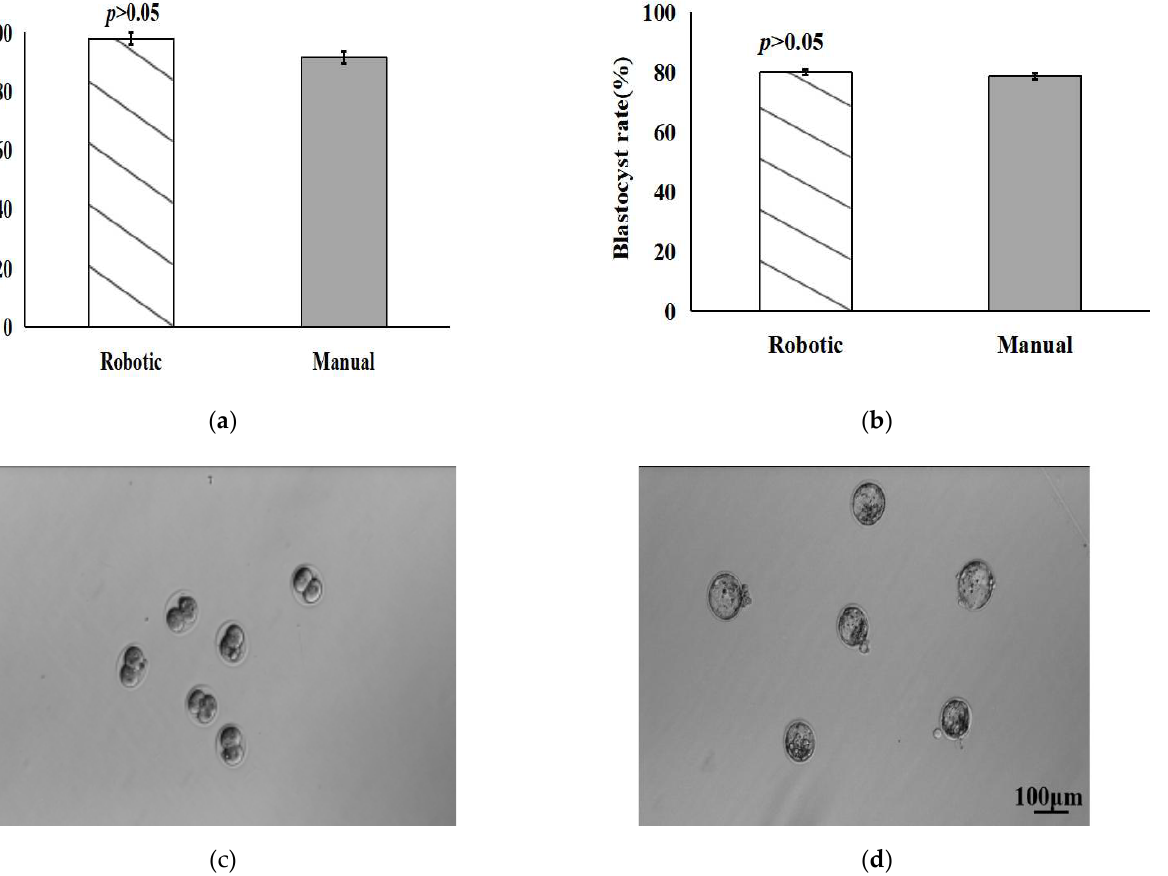
Figure 10. Fertilization and development potentials of oocytes denuded by robotic system and manual operation for ICSI. ( a , b ) Fertilization rate of oocytes denuded and blastocyst rate of two-cell embryos; ( c , d ) Representative images of two-cell embryos and blastocysts produced by ICSI.